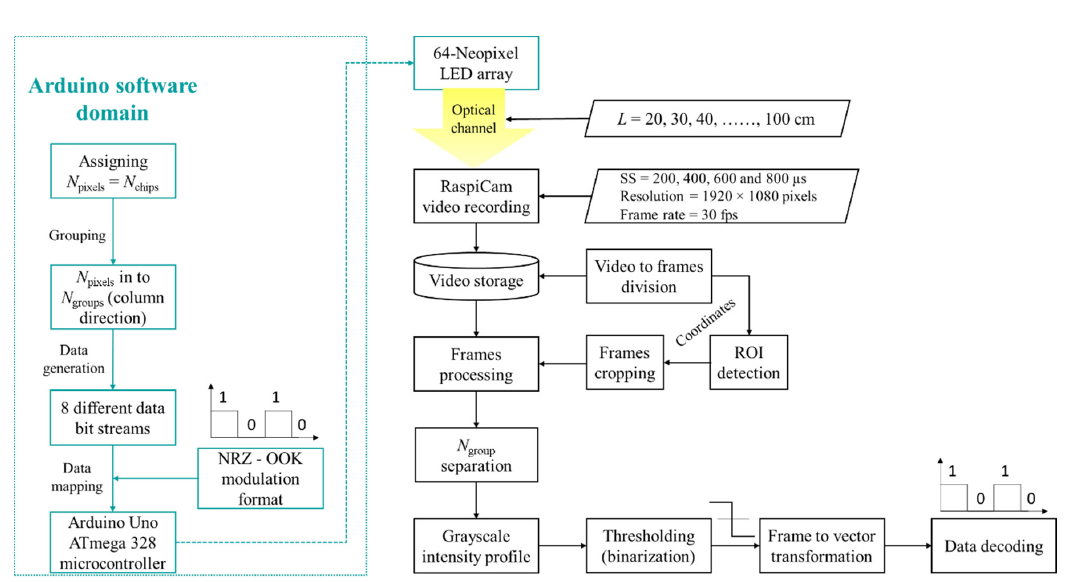
Figure 5. MIMO ‐ OCC data processing flow diagram. Figure 5. MIMO-OCC data processing flow